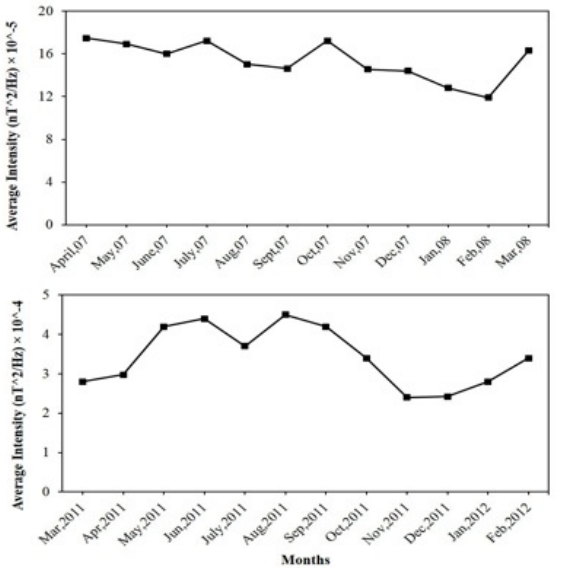
Figure 4(c). Seasonal variation of first mode intensity for the two periods.